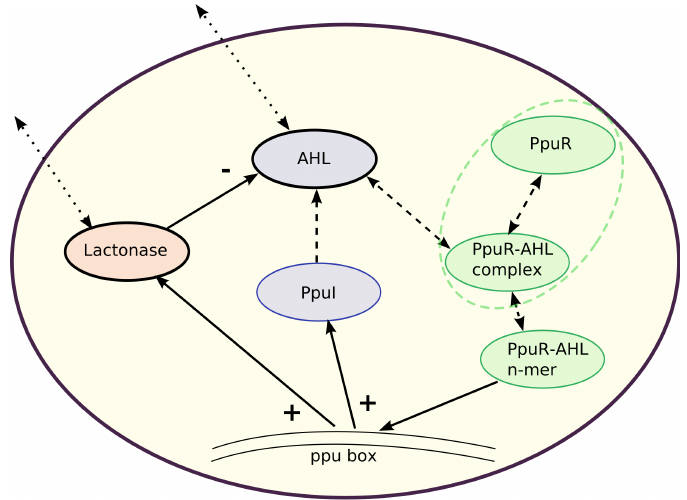
Figure 1. Model structure for the quorum sensing system in one Pseudomonas putida cell. N -Acyl homoserine lactone (AHL) concentration is regulated by a (self-induced) positive feedback ( + ) as well as by a negative feedback ( − ) via the AHL-degrading enzyme Lactonase. The transcriptional activator PpuR binds to AHL forming a PpuR–AHL complex, which polymerizes. PpuR–AHL n -mers bind to the AHL-dependent quorum sensing locus (ppu-box) and synthesize PpuI. This protein is finally responsible for AHL synthesis. Similarly, PpuR-AHL n -mers induce synthesis of Lactonase molecules. Feedbacks on the transcription of PpuR are neglected. Solid arrows represent activations and inhibitions. Dashed arrows indicate reactions and processes which are partially assumed to be in quasi-steady state. Dotted arrows represent the possible exchange of substances between intracellular and extracellular space. The dashed green ellipse refers to the special case in model version (4), where it is assumed that the total amount of PpuR in one cell (consisting of PpuR and the PpuR-AHL complex) is constant whereas in the other models, PpuR and the PpuR-AHL complex follow their own